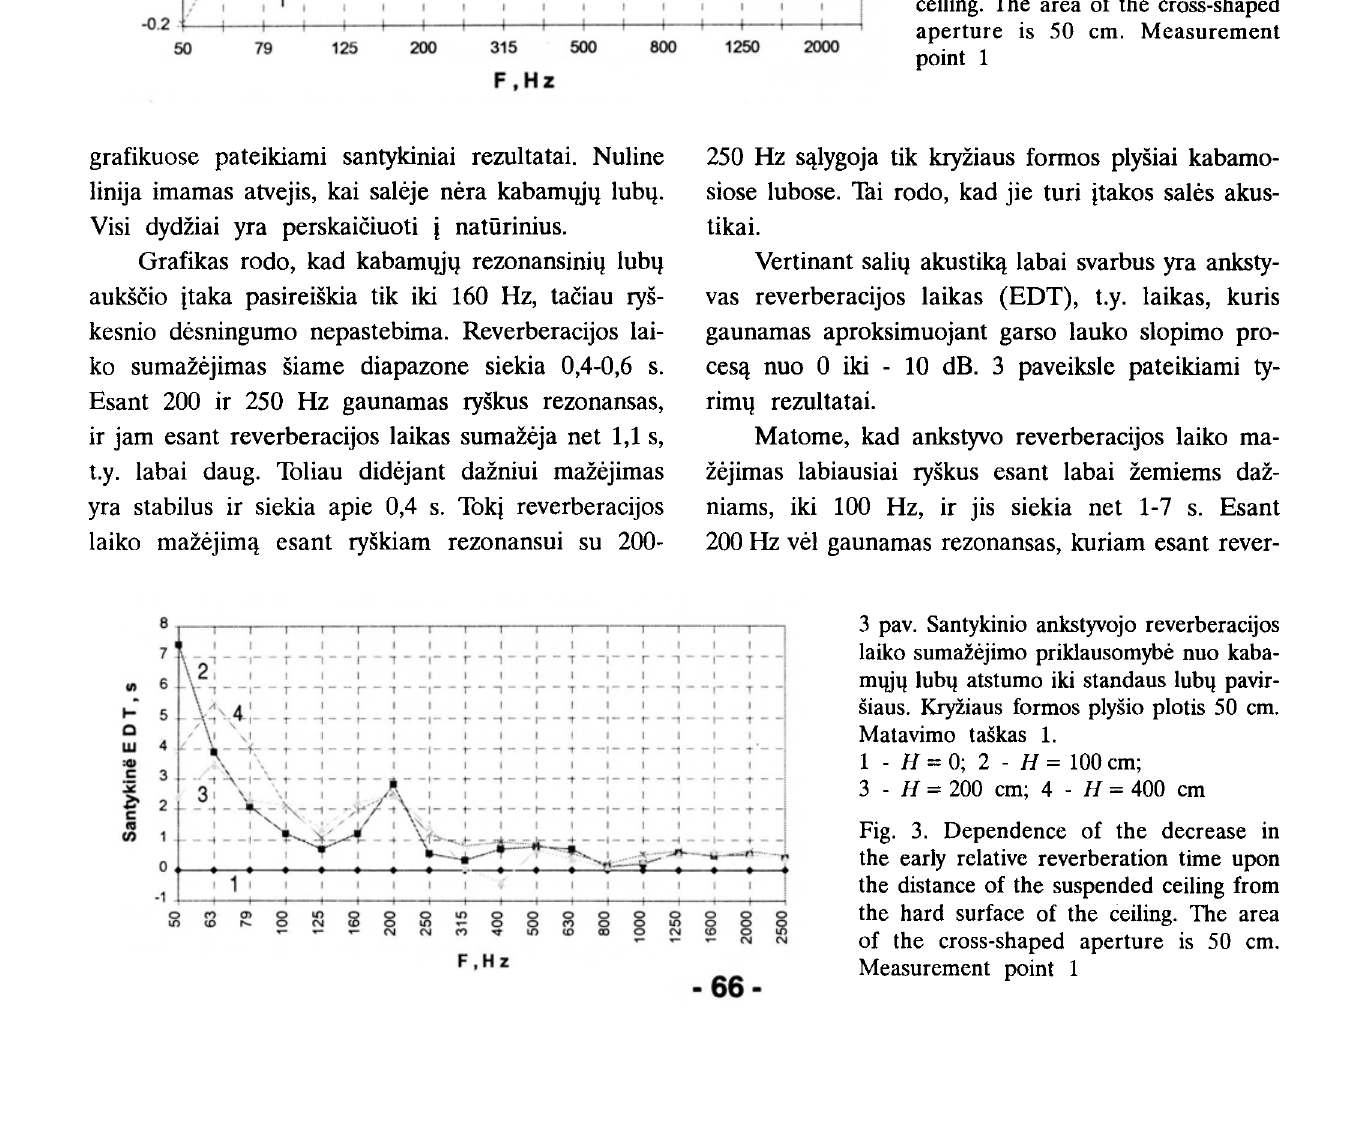
Fig. 2. Relative dependence of the decrease in the reverberation time upon the distance of the suspended ceiling from the hard surface of the ceiling. The area of the cross-shaped aperture is 50 em. Measurement point 1